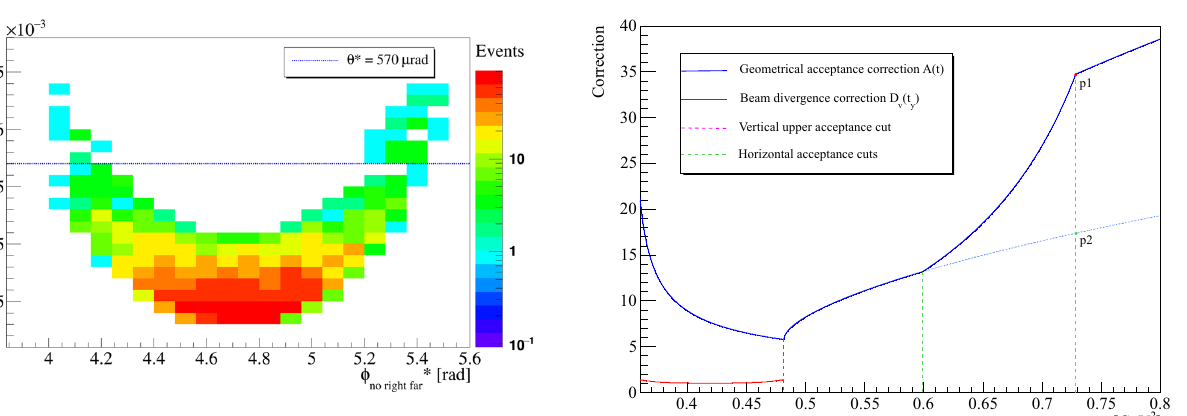
Fig. 5 The uncorrected distribution of the azimuthal angles φ ∗ per event as a function of θ ∗ in Diagonal 1. The consecutive empty bins Fig. 6 The geometrical acceptance correction A ( t ) and the vertical along the θ ∗ = 570 µ rad line are due to the diffractive minimum at beam divergence correction D v ( t y ) for Diagonal 1. The vertical lines t ≈ − 0 . 61 GeV 2 , see Fig. 8. In order to optimize the acceptance the indicate the | t | -positions where the additional acceptance limitations right far RP was not used, denoted in φ ∗ , see also Sect. 3.1.3 no right far appearduetotheverticalandhorizontalLHCapertures.Thedashedblue line indicates a hypothetical geometrical correction without horizontal acceptance cuts. The ordinate of point p 1 is two times the ordinate of p 2 at the upper horizontal cut, since the acceptance is halved by the cut at the LHC aperture